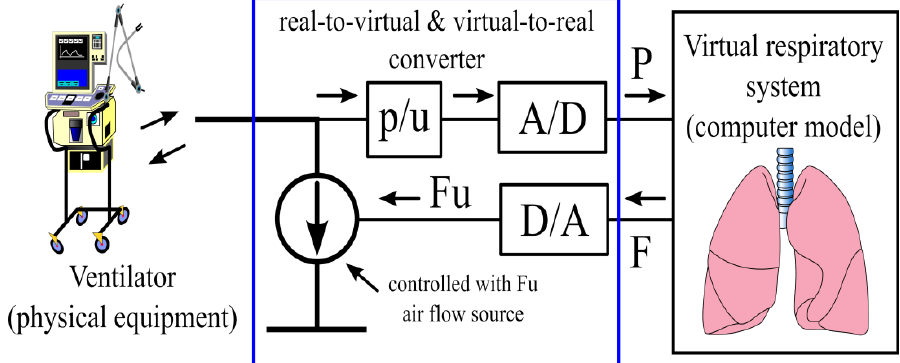
Figure 2. An example of the physical – numerical interface: A real ventilator ventilates the tube that simulates the trachea. Without respect to the type of a respirator and the support mode, the respirator work changes the pressure in the tube. That pressure is measured and converted to voltage ([p/U]), which after digitization ([A/D]) is the input (P) of a computer model. The model calculates the air flow (F) that would be for the measured pressure course in a real patient. This calculated value (converted to voltage Fu) controls the air flow source; in consequence, a quantity of the real air flows through the tube. Such flow causes a pressure change in the tube as though the air has gone to/from the real lungs. Thus, from the respirator point of view, it ventilates a real